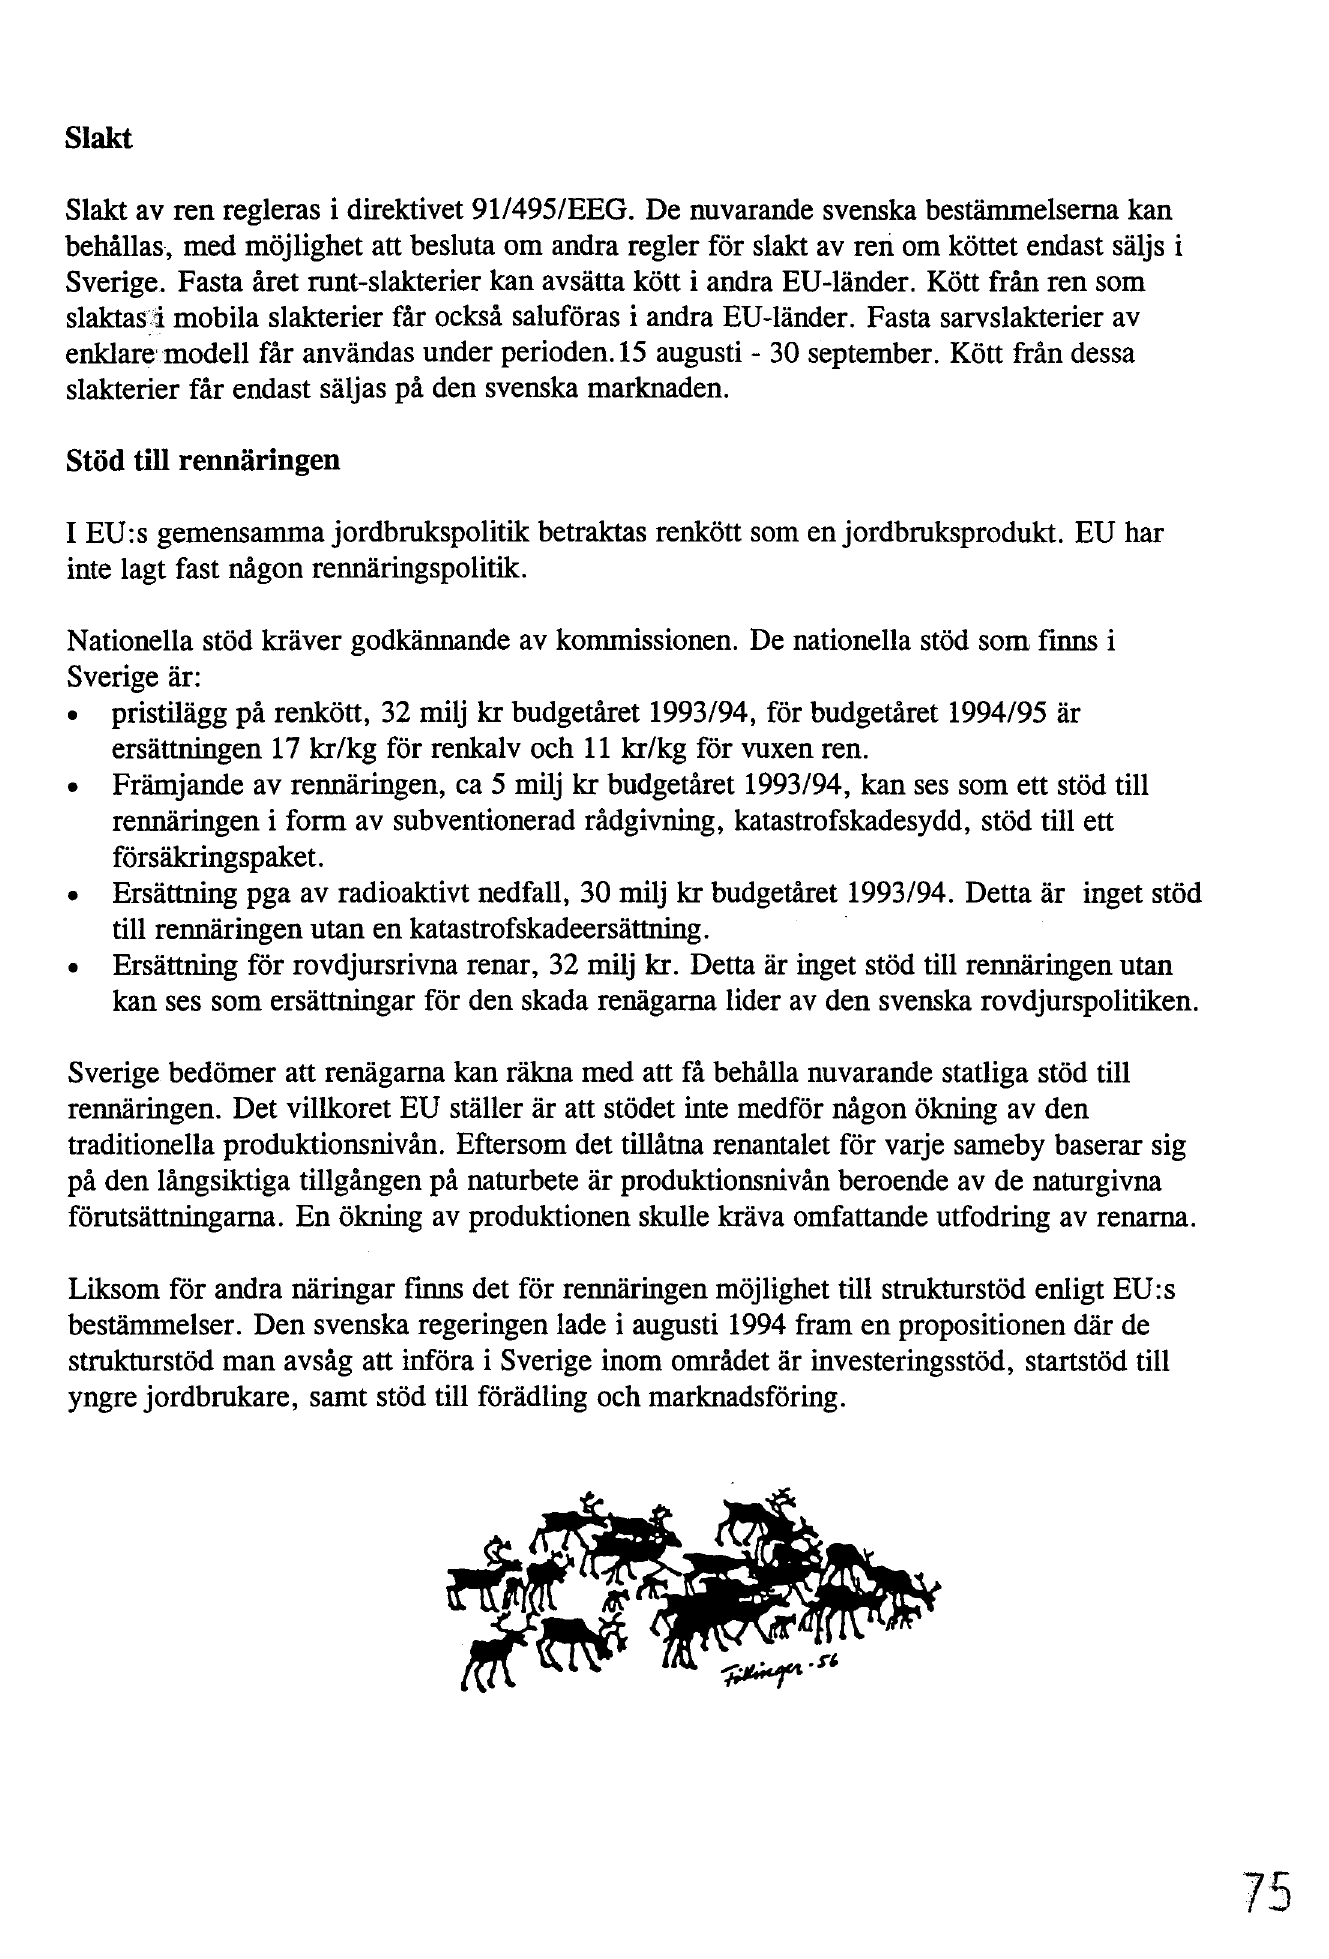
Slakt Slakt av ren regleras i direktivet 91/495/EEG. De nuvarande svenska beståmmelserna kan behållas, med mojlighet att besluta om andra regler for slakt av ren om kottet endast såljs i Sverige. Fasta året runt-slakterier kan avsåtta kott i andra EU-lånder. Kott från ren som slaktas! mobila slakterier får också saluforas i andra EU-lånder. Fasta sarvslakterier av enklare modell får anvåndas under perioden. 15 augusti - 30 september. Kott från dessa slakterier får endast såljas på den svenska marknaden.